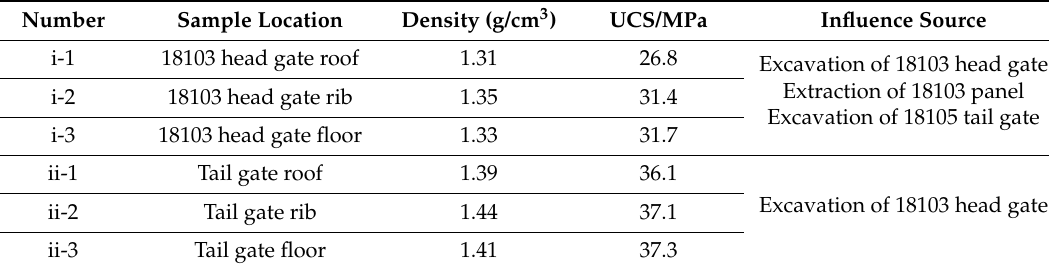
Figure 7. Uniaxial compressive strength (UCS) of coal specimens at different locations. The test result showed that the density and uniaxial compressive strength of coal samples obtained from triangular coal pillar were less than that from solid coal area with a difference of about 5.6–9.3 MPa. The strength of coal at the top was less than the middle and bottom at the triangular coal pillar side. However, the strength of coal at the different locations at the solid coal was similar. This indicates that triangular coal was greatly influenced by mining, microcracks were generated within the surrounding rock mass, and cohesion and internal friction decreased. Therefore, the uniaxial compressive strength as well as the density were both smaller. According to Mohr–Coulomb criterion, the relationship between UCS, cohesion, and angle of internal friction is [17]